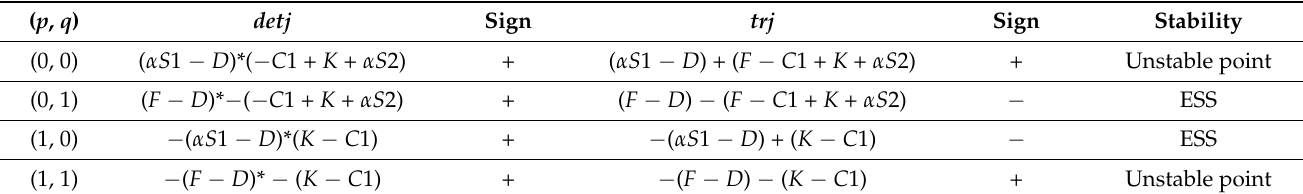
Table 3. Stability analysis results.